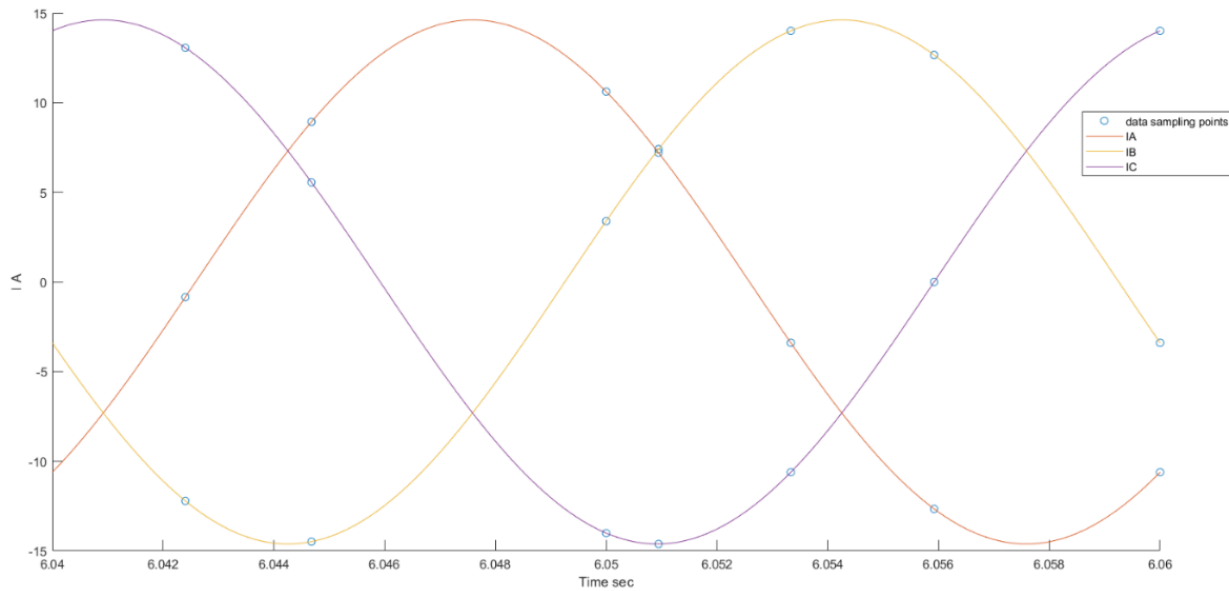
Figure 13. Visual representation of the data preprocessing result.